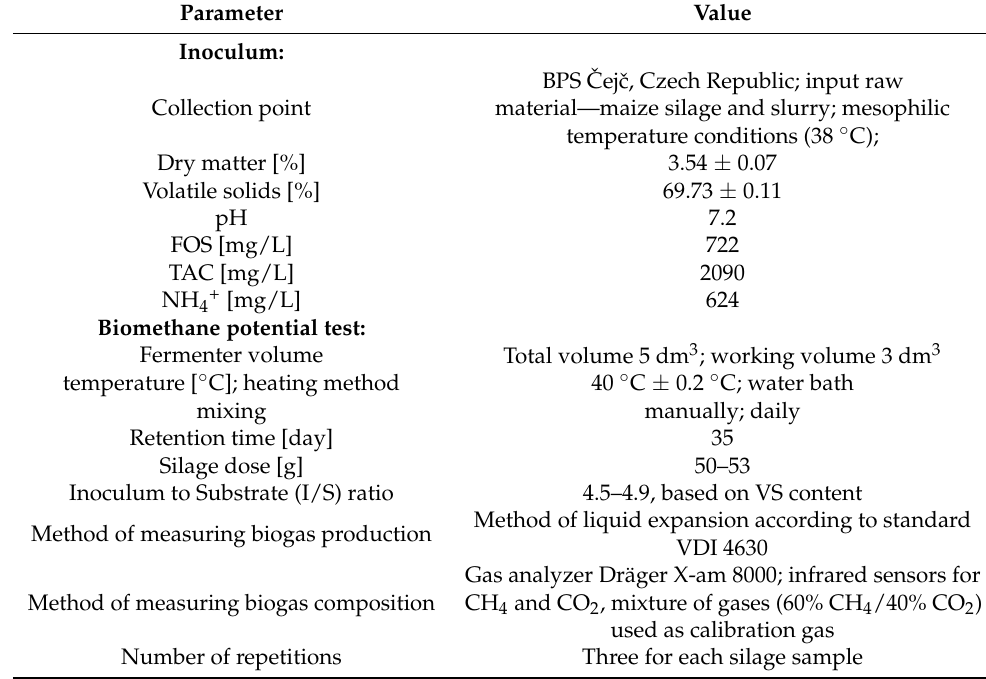
Table 3. Inoculum characteristics and parameters of the test of methane